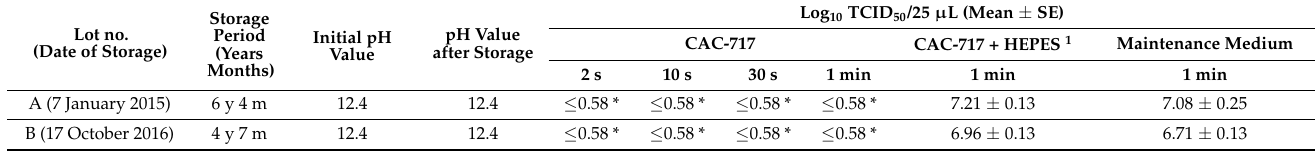
Table 7. Virucidal effect of CAC-717 on IBRV after long-term storage at room